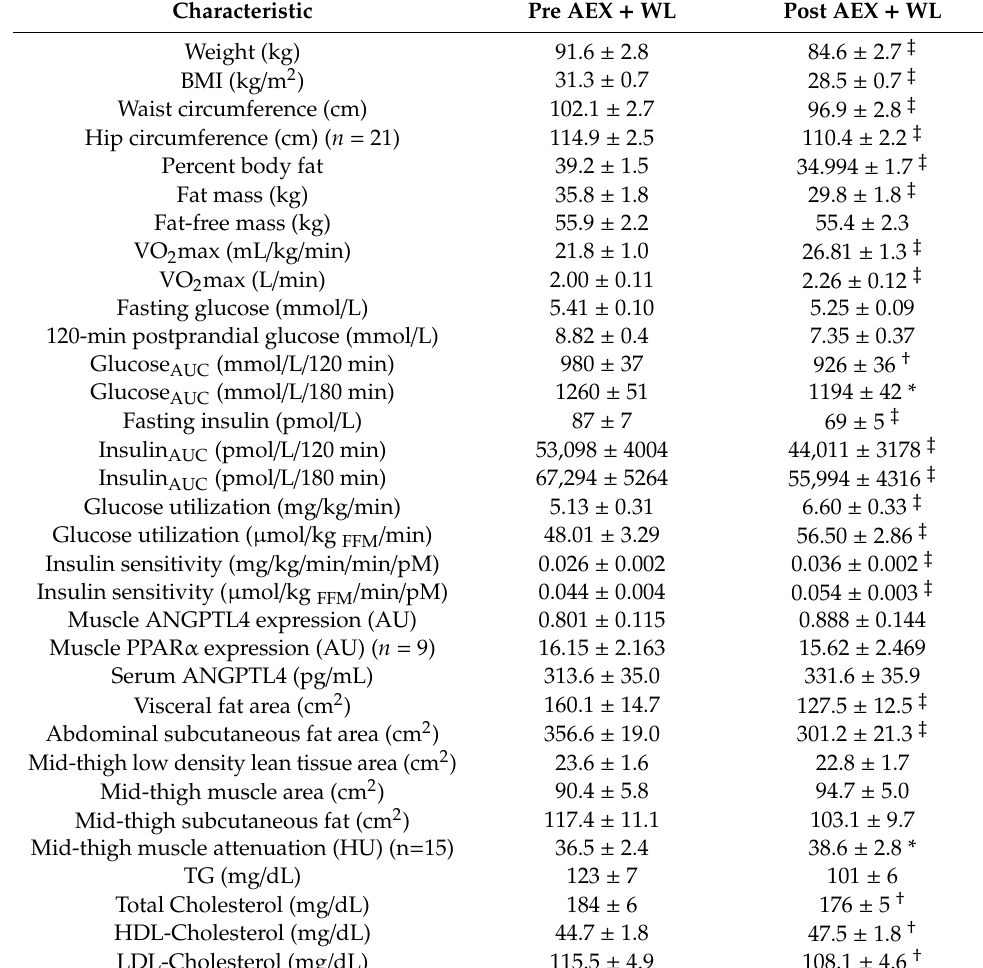
Table 1. Physical and metabolic characteristics and gene expression of all subjects ( n = 35) before and after aerobic exercise + weight loss (AEX + WL)